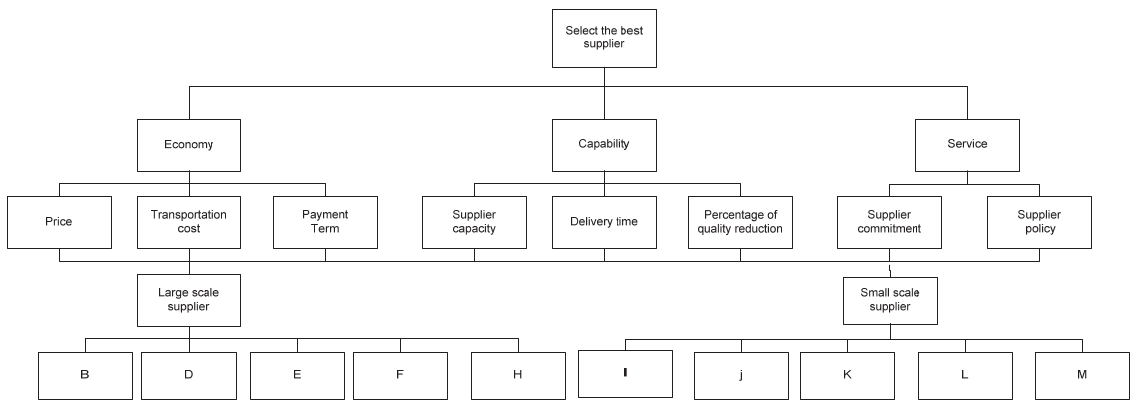
Fig. 2. AHP model for supplier